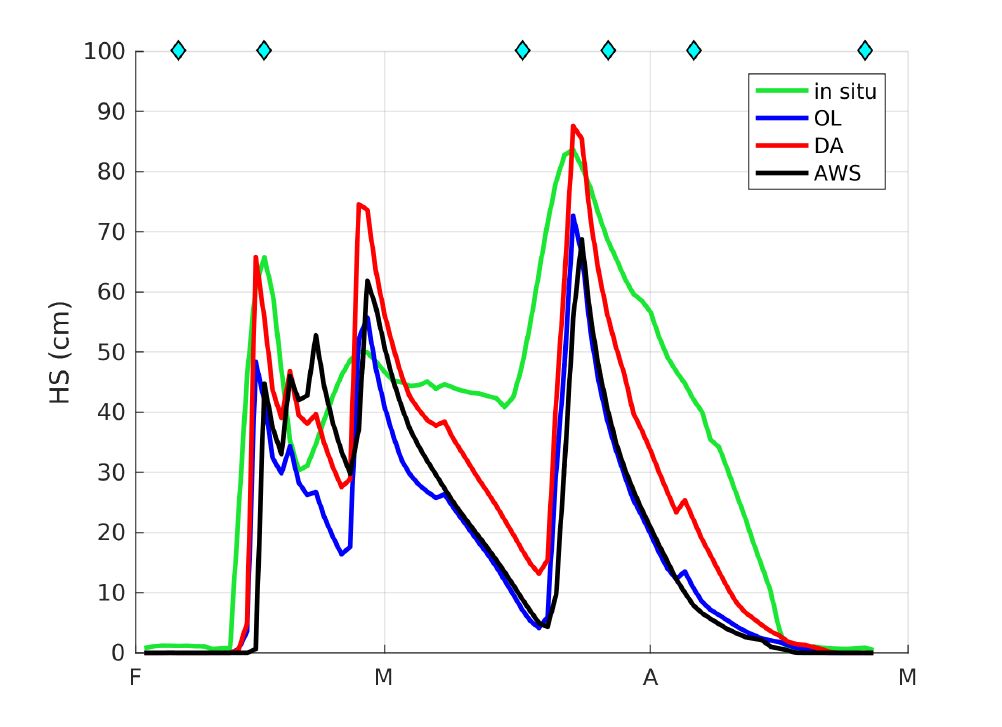
Figure 8. Comparison of the simulated and observed in situ snow height in Oukaimeden at the daily time step. The blue diamonds in the upper part of the figure indicate the date of the assimilated Sentinel-2 observations. OL: open loop snow height, DA: data assimilation snow height, AWS: modeled snow height using automatic weather stations forcing. Table 3. RMSE and correlation between modeled and observed (i) daily snow height (HS) and (ii) snow cover fraction over the catchment area (cSCF)(%) from 01 September to 01 May. HS was measured